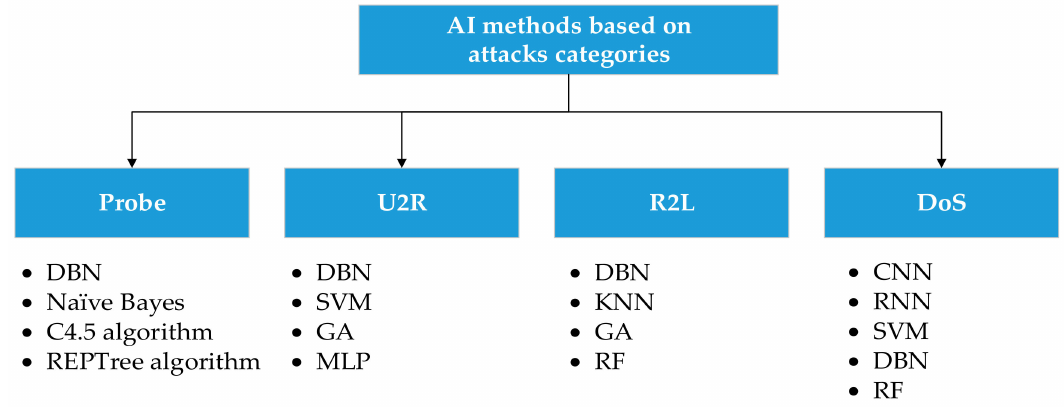
Figure 8. Illustration of artificial intelligence methods based on attacks